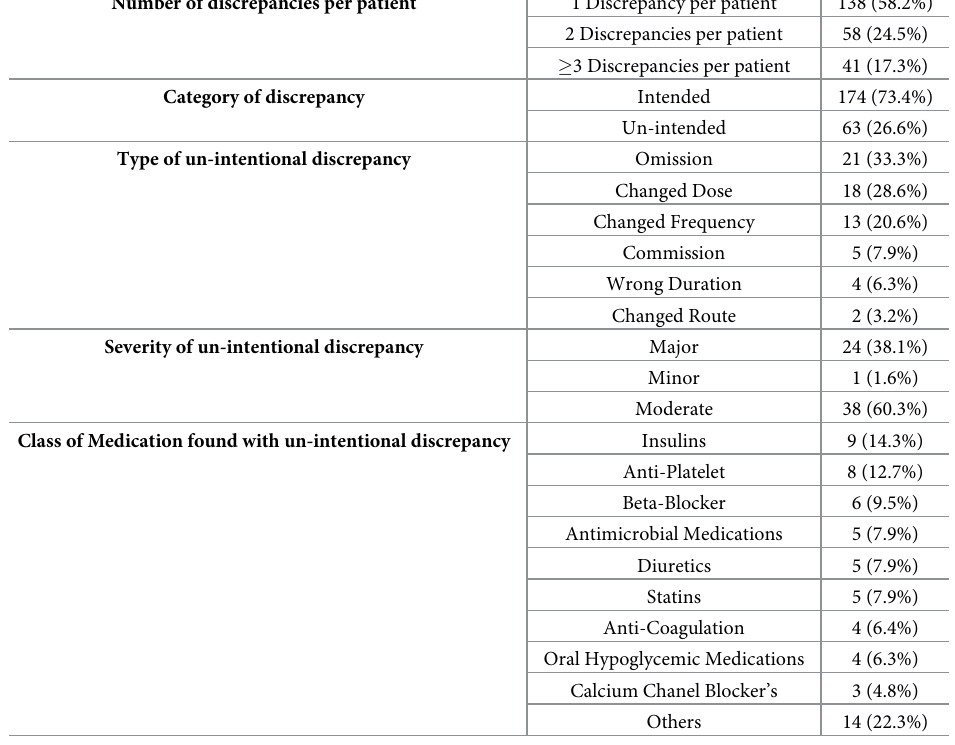
antiplatelet (Aspirin and Clopidogrel), beta-blocker, and statin and diuretics, accounting for 14.3%, 12.7%, 9.5%, and 7.9%, respectively. Table 2 revealed the discrepancies of the other classes of medications found in this study. Of the 63 unintentional medication discrepancies identified during patient discharge, the most type of medication discrepancy was an omission of medication by 21 (33.3%), followed by dose changed by 18 (28.6%), (Table 2). The severity of discrepancies encountered was primar- ily classified as major and moderate accounting for over 62 (98%) of unintended discrepancies (Table 2). Table 2. Clinical characteristics of patients.